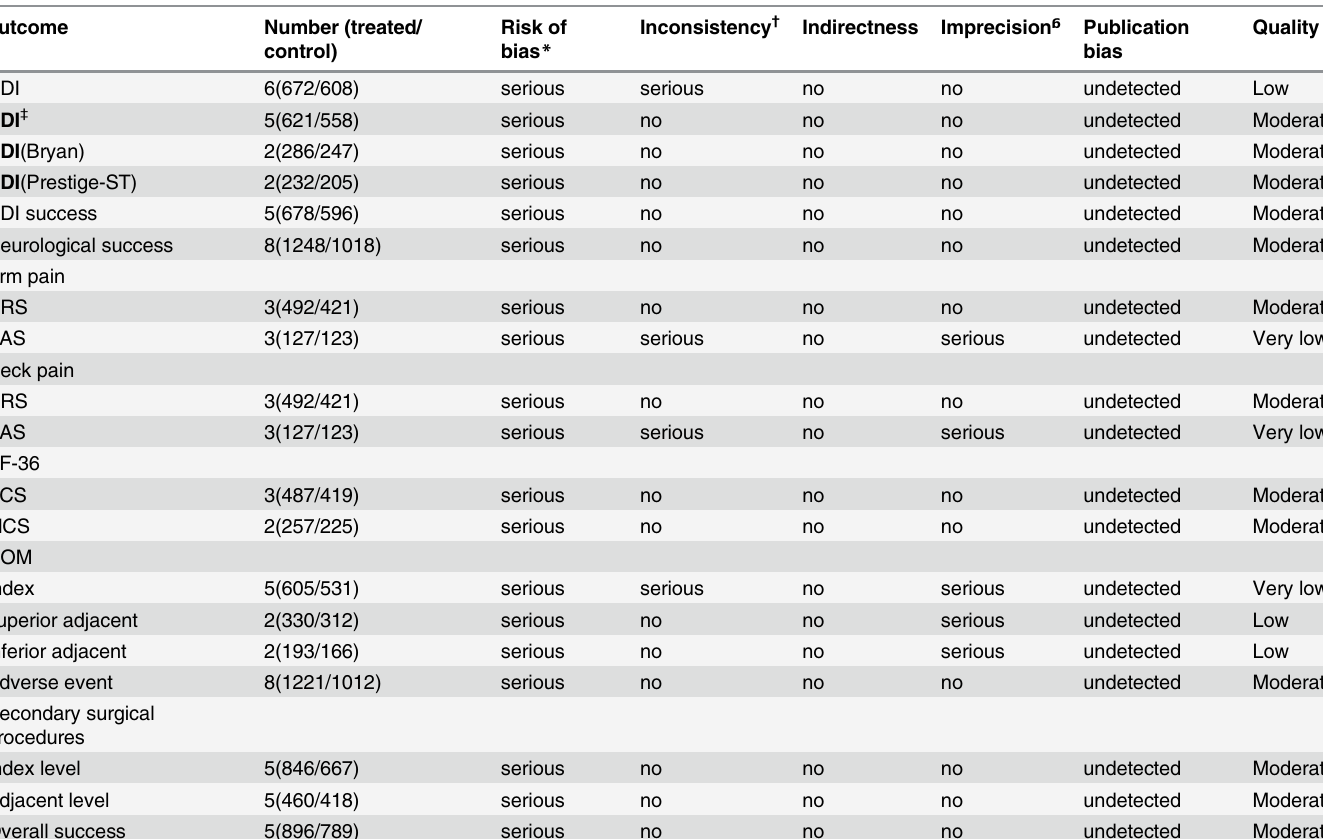
Table 3. GRADE evidence pro fi le of RCTs for compare CTDR and ACDF in short-term follow-up. outcome